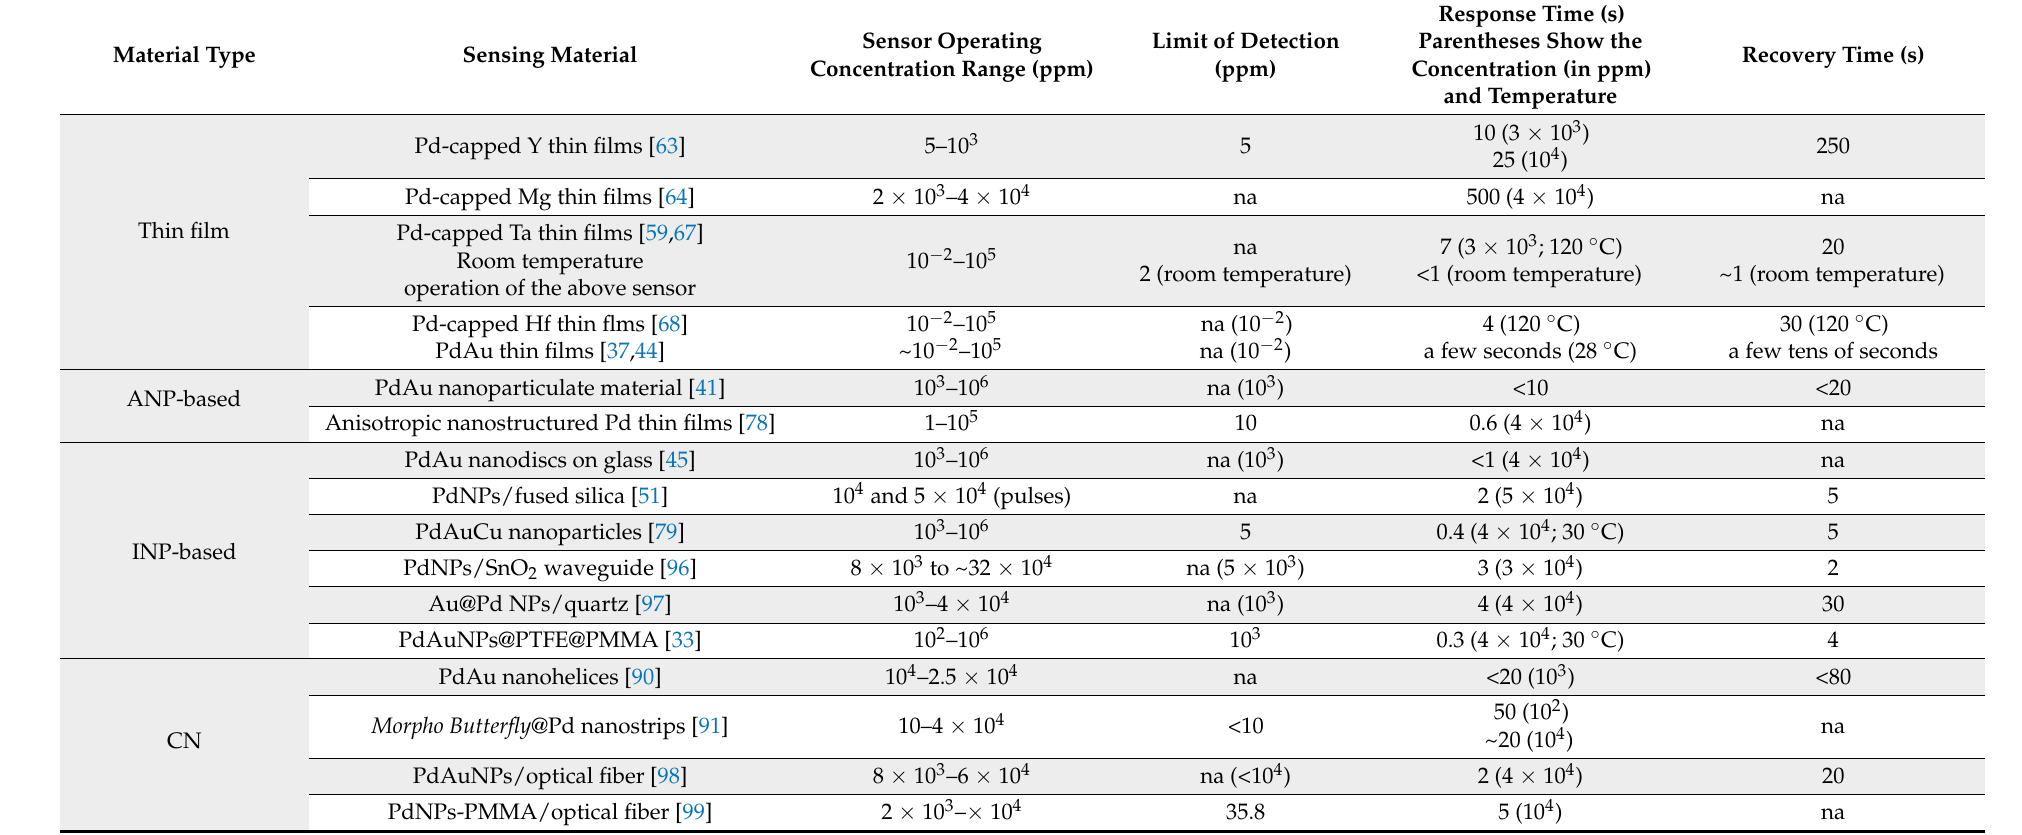
Table 1. Performance characteristics of Pd-based thin films and materials based on ANP, INP, or CNs for optical H 2 gas sensors. In all cases, the sensors were operated at room temperature unless noted otherwise. For many materials (second column) the limit of detection is not directly measured, but only the lowest hydrogen concentration at which the testes were made is provided (third column). The fourth column gives the lowest detectable value (experimentally and not material limited). The fifth and sixth column provide the reported response and the recovery times of the materials at specific H 2 concentrations and in some cases measurements that deviate from ambient (numbers in brackets). Key: NPs stands for nanoparticles, and na for not